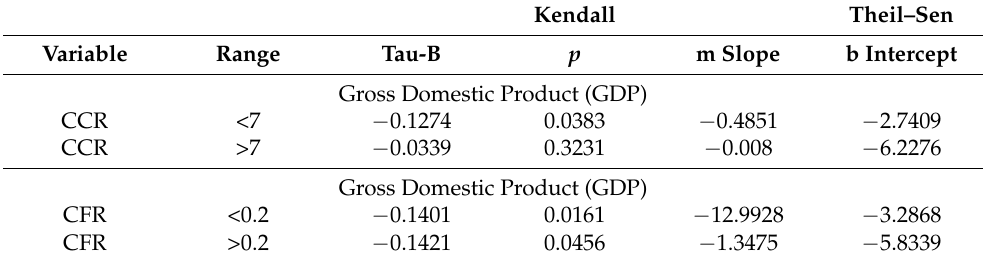
Table 4. Results of statistical tests using the Kendall tau-b of relations between CCR, CFR, and the change in GDP relative increase (GDP) with Theil–Sen slopes (m) and intercepts (b) of trend lines approximating these